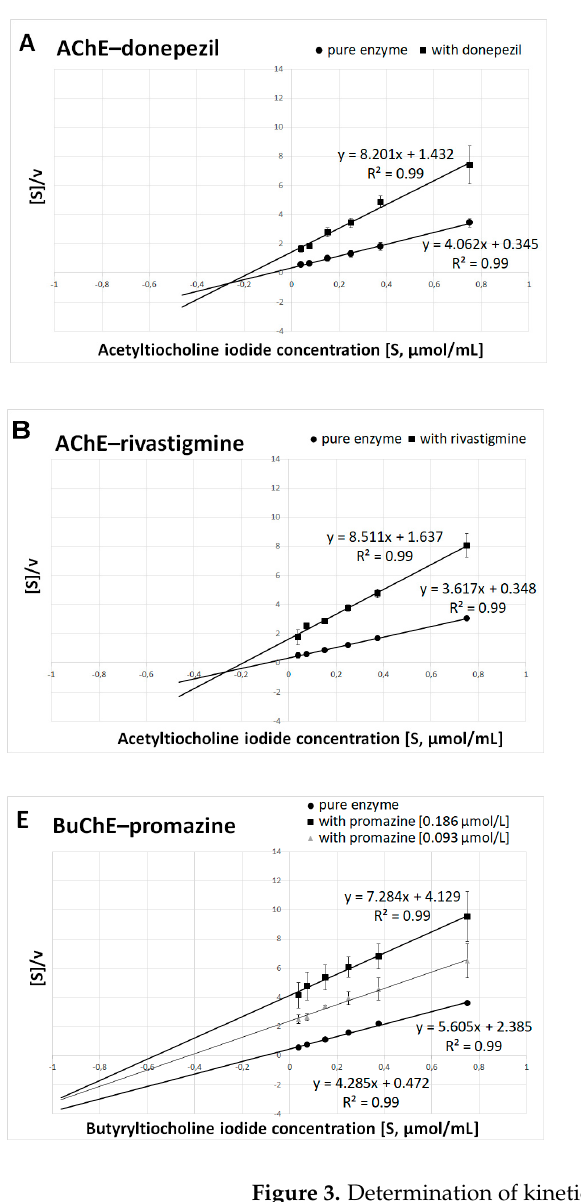
Figure 3. Determination of kinetic parameters of enzymatic reactions. The Hanes–Woolf plots were used to calculate the maximal velocity ( V max ) and the Michaelis–Menten constant ( K m ). ( A ) AChE and donepezil at a concentration of 0.025 µ mol/L. ( B ) AChE and rivastigmine at a concentration of 64.29 µ mol/L. ( C ) BuChE and donepezil at a concentration of 12.81 µ mol/L. ( D ) BuChE and rivastigmine at a concentration of 0.95 µ mol/L. ( E ) BuChE and promazine at a concentration of IC 50 = 0.186 µ mol/L and 1 / 2 IC 50 = 0.093 µ mol/L. ( F ) BuChE and quetiapine at a concentration of IC 50 = 6.08 µ mol/L and 1 / 2 IC 50 = 3.04 µ mol/L. Results are presented as mean ± SD for two or three independent experiments, conducted in duplicates on various erythrocytes for AChE and plasma for BuChE.